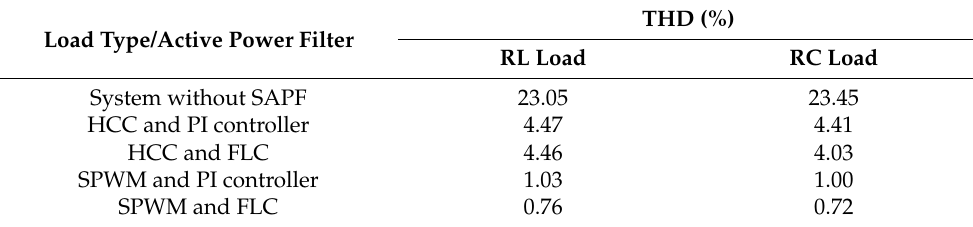
Table 3. THD analyses of the proposed model at different load operating conditions with differ- ent controllers.